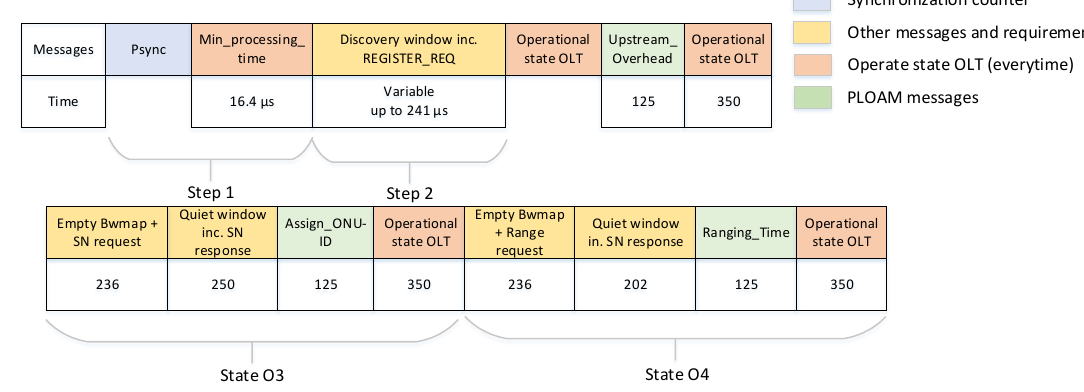
Figure 11. Visualization of the optimized GPON activation